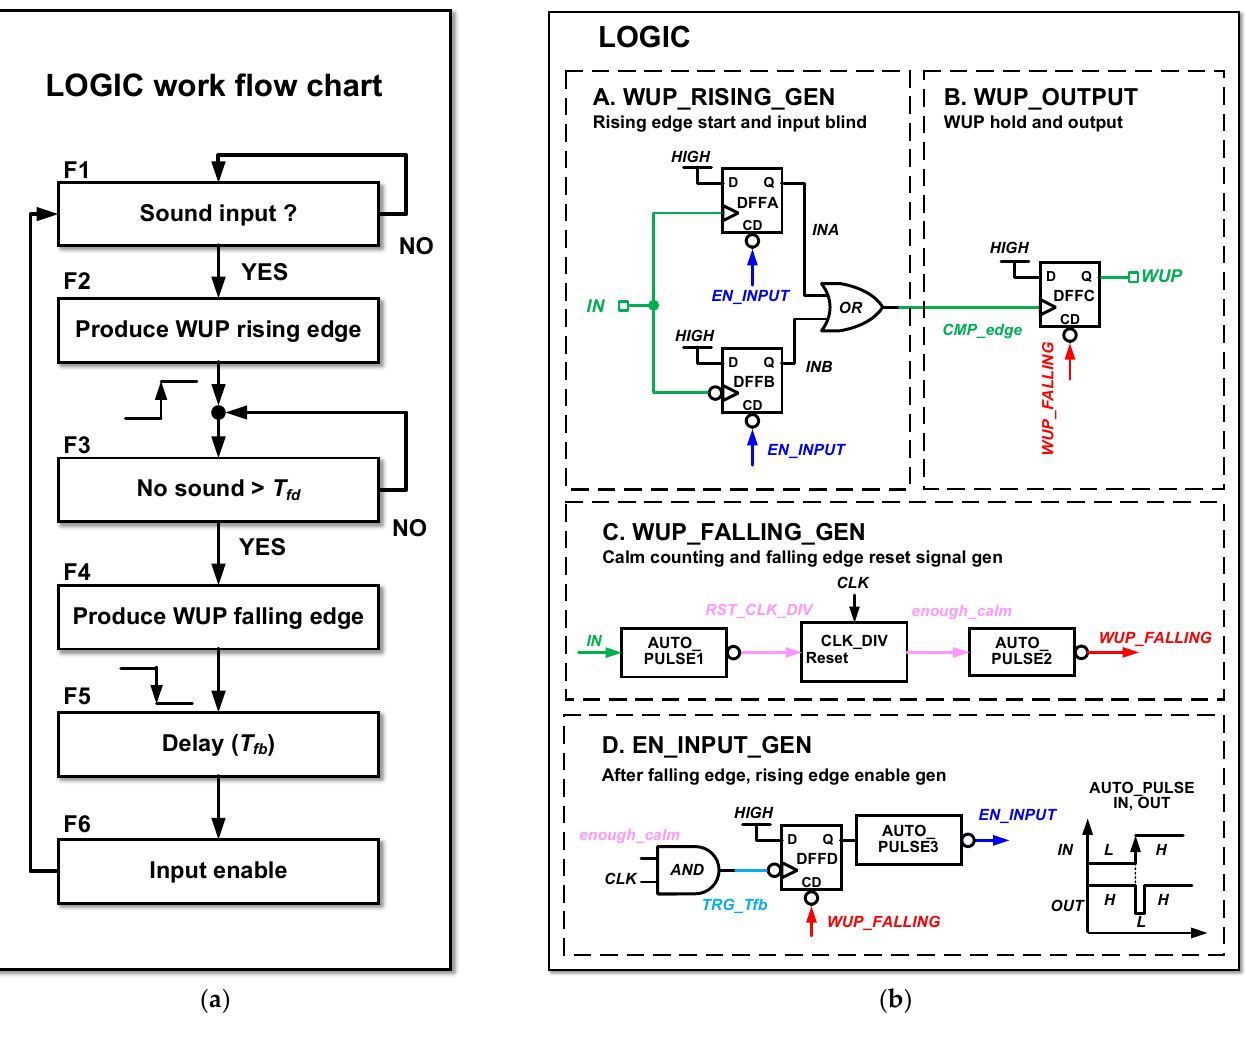
Figure 11. Workflow and circuit of LOGIC: ( a ) Working flow chart; ( b ) Detailed circuit diagram.